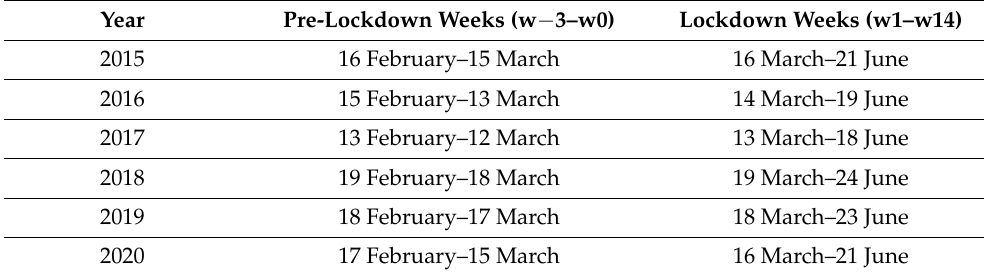
Table 3. Corresponding selected pre-lockdown and lockdown weeks for the years 2015–2019